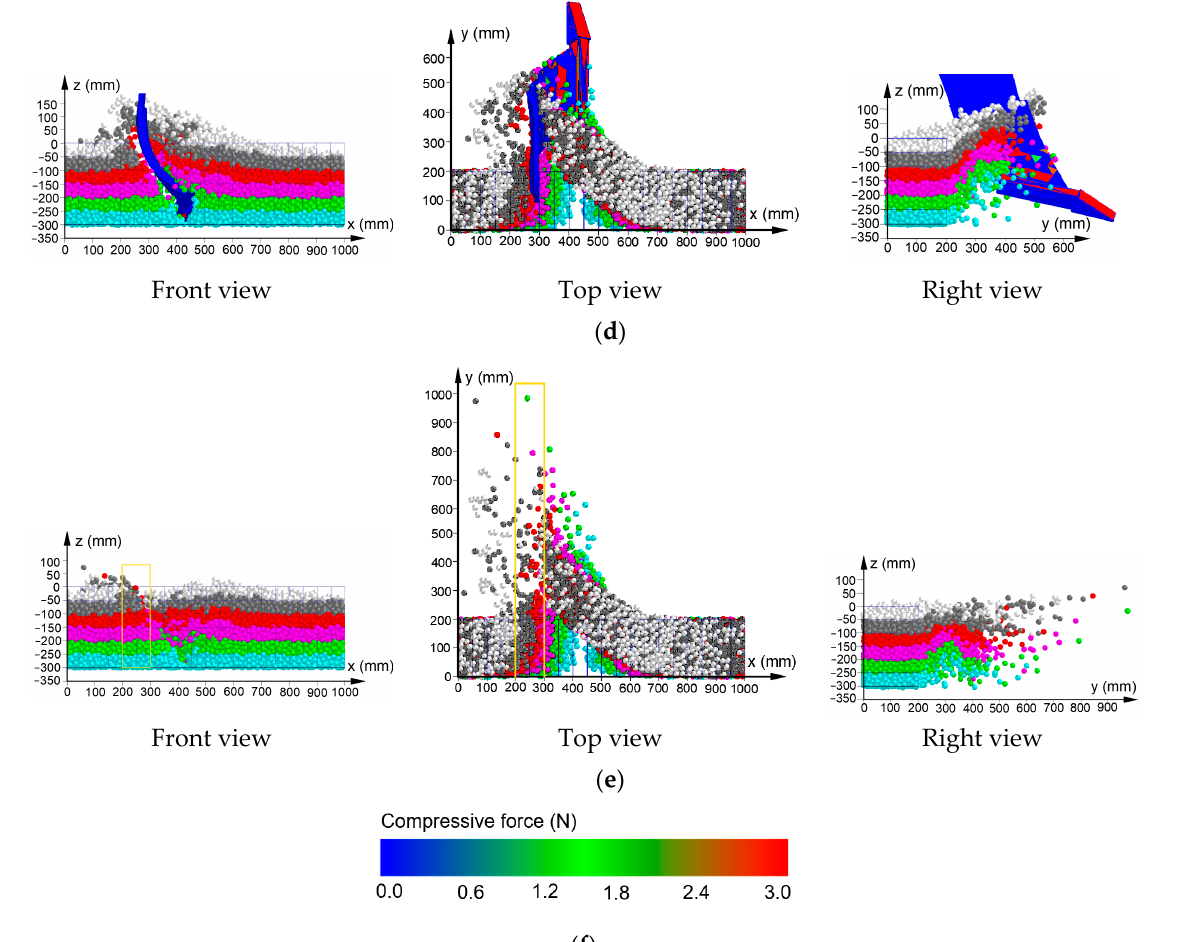
Figure 6. Microcosmic process of soil disturbance of the bending subsoiling tool: ( a ) t 1 = 3.92 s; ( b ) t 2 = 4.16 s; ( c ) t 3 = 4.4 s; ( d ) t 4 = 4.6 s; ( e ) t 5 = 5.2 s; and ( f ) the legend for compressive force on the bending subsoiling tool surface.